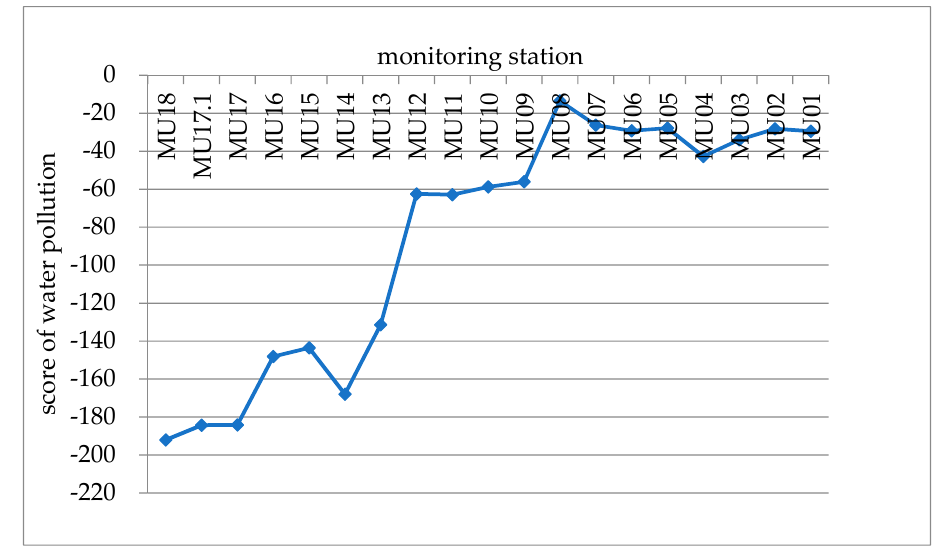
Figure 5. Comprehensive score of water pollution during the dry season.